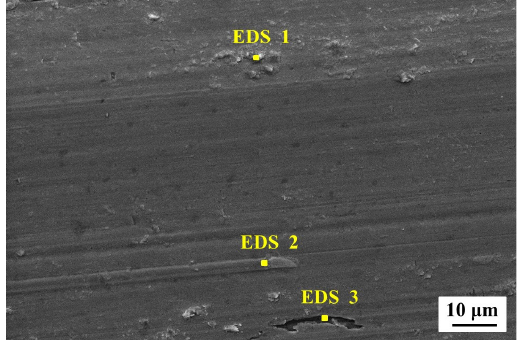
Figure 10. Schematic representation of the precipitation particle (carbides and sul fi des) behavior during the pin-on-disc sliding wear test.